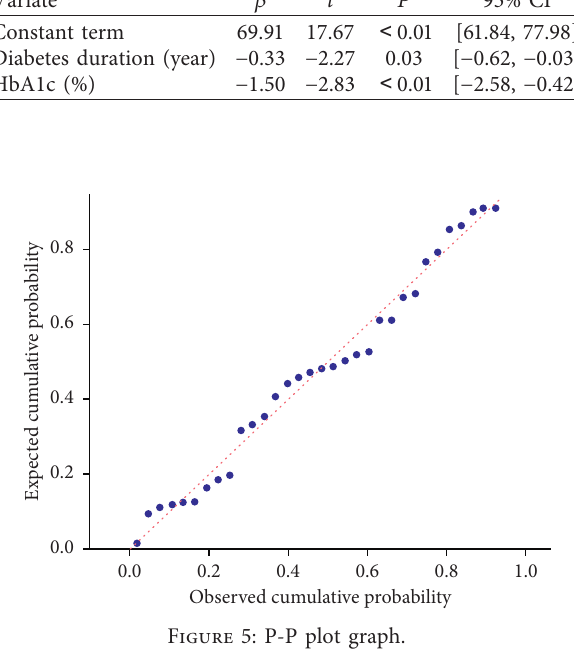
Figure 5: P-P plot graph.